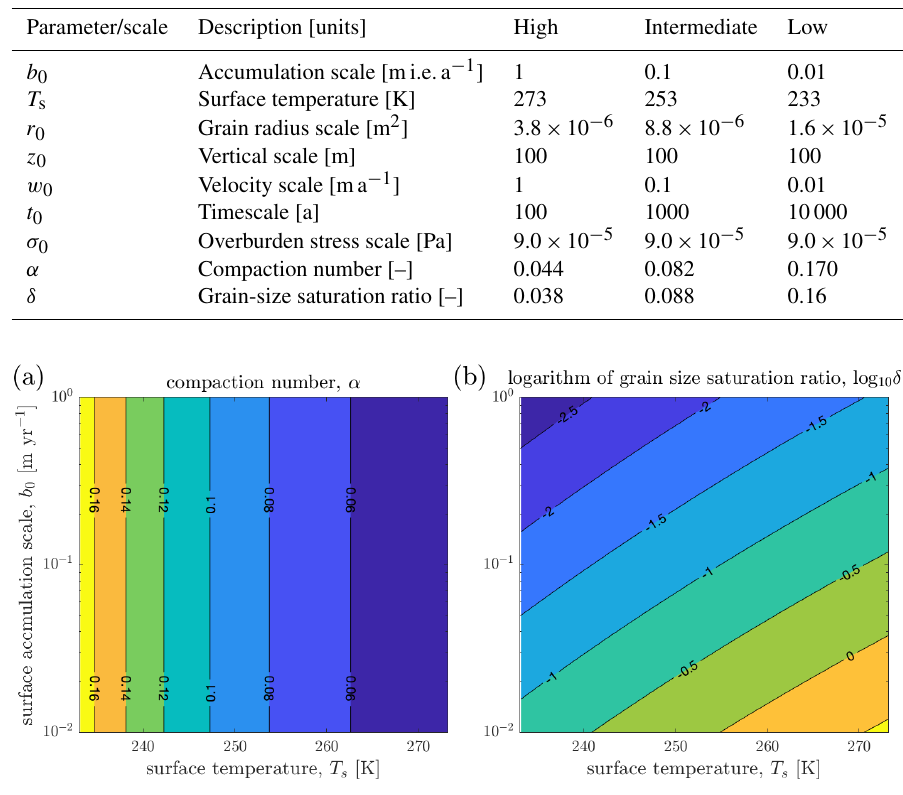
Table 3. Surface temperatures, scales, and nondimensional parameters corresponding to three climatic settings: (1) high accumulation and surface temperature (e.g. a mountain glacier in a maritime climate), (2) intermediate temperature and accumulation (e.g. near-coastal Antarc- tica), and (3) low temperature and accumulation (e.g. interior East Antarctica). Ice equivalent: i.e.